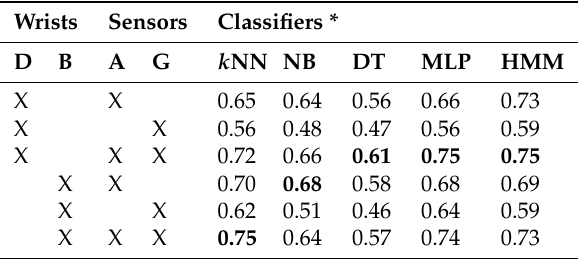
Table 4. Accuracy of the classification using accelerometer (A) and/or gyroscope (G) data from the dominant (D) vs. both (B)